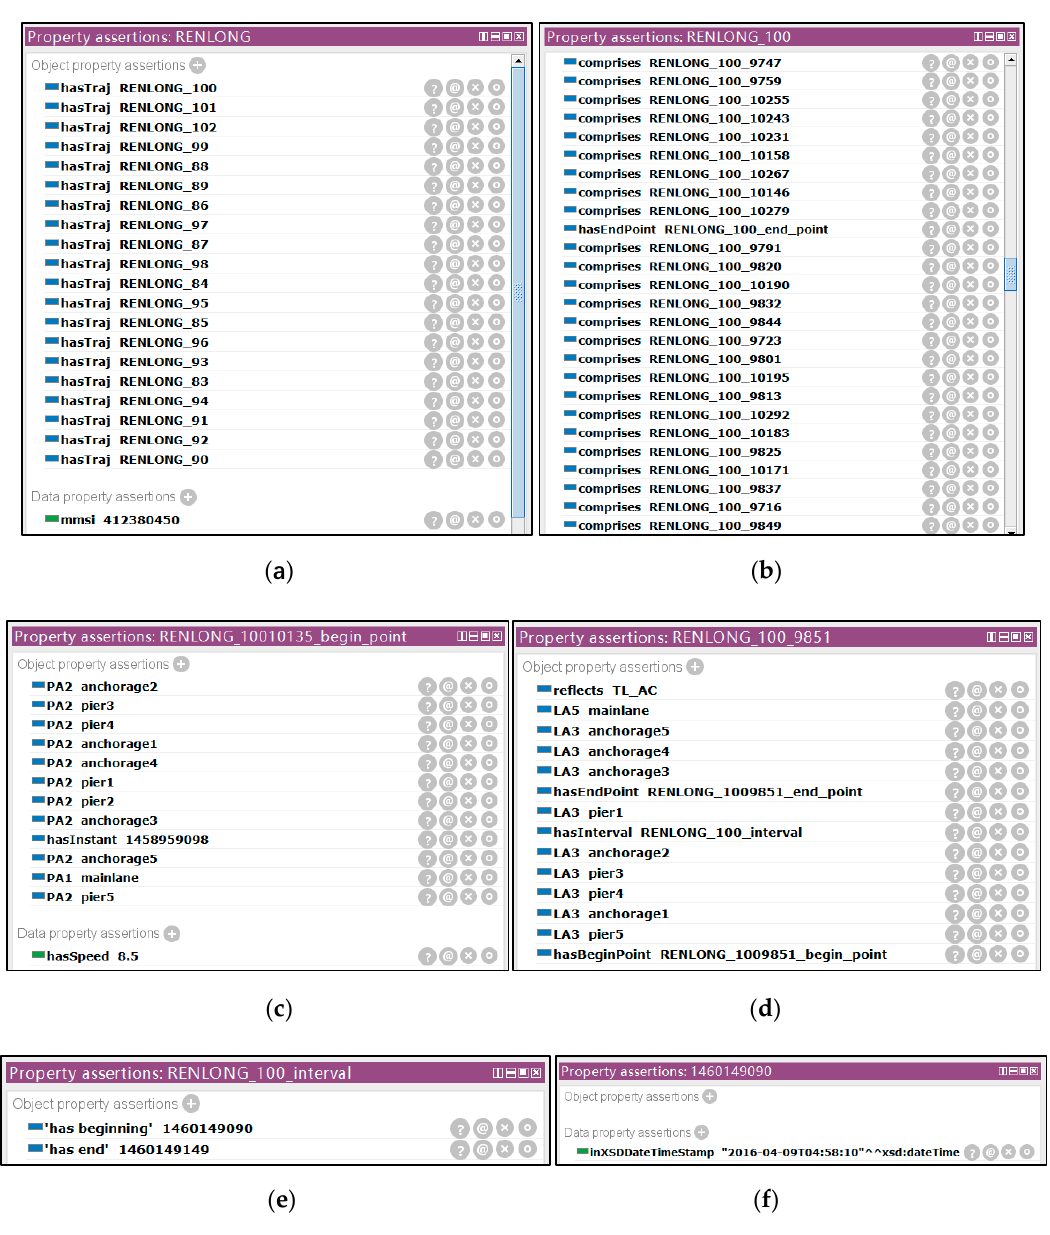
Figure 10. The importing result of ship behavior. ( a ) The trajectories occurred by RENLONG; ( b ) The sub-trajectories and key points of trajectory RENLONG_100; ( c ) The spatial topological relationships with surroundings for RENLONG_10010135_begin_point; ( d ) The spatial topological relationships with surroundings for RENLONG_100_9851; ( e ) The instant properties of RENLONG_100_interval; ( f ) The XSD date timestamp property corresponding to the moment 1460149090.